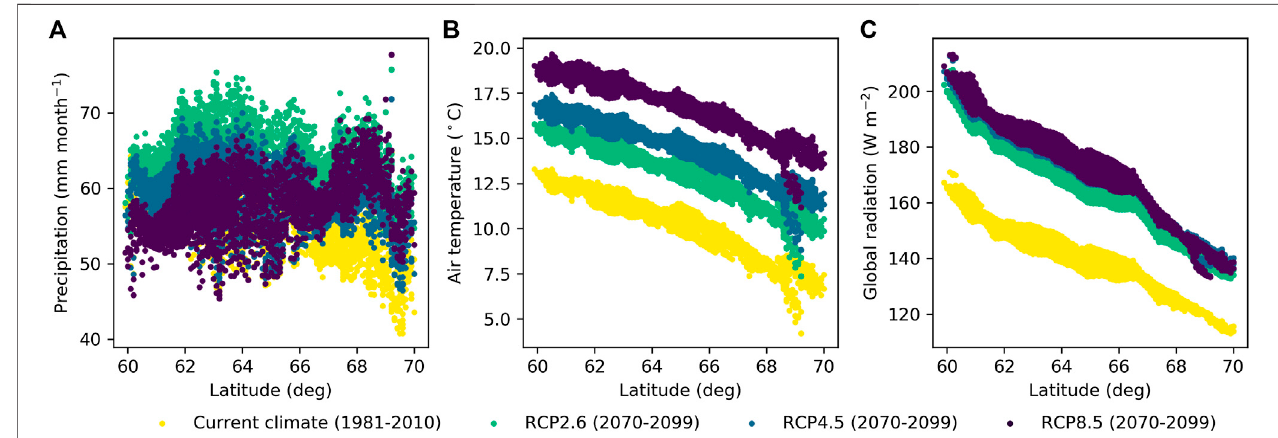
FIGURE 10 | Mean June – October (A) precipitation, (B) air temperature, and (C) global radiation along latitudinal gradient in Finland derived from global climate models for current climate and future climate with representative concentration pathways RCP2.6, RCP4.5, and RCP8.5.